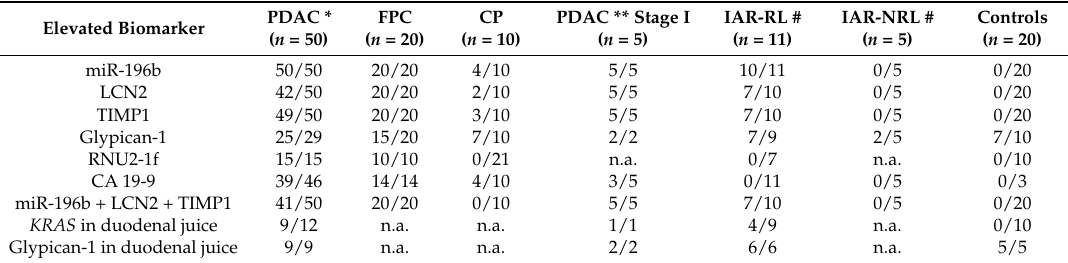
Table 2. Biomarker results of patients with pathologically defined